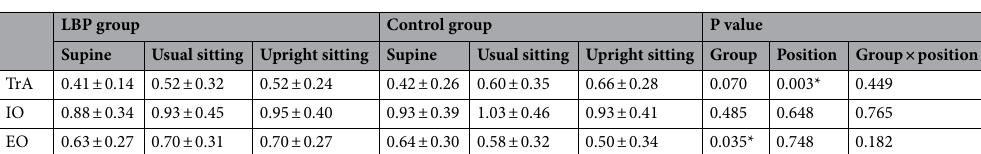
Table 3. Comparison of muscle thickness between the low back pain and control groups according to position. Data are expressed as mean ± SD. LBP low back pain, TrA transverse abdominis muscle, IO internal oblique muscle, EO external oblique muscle. *Means that P value is under